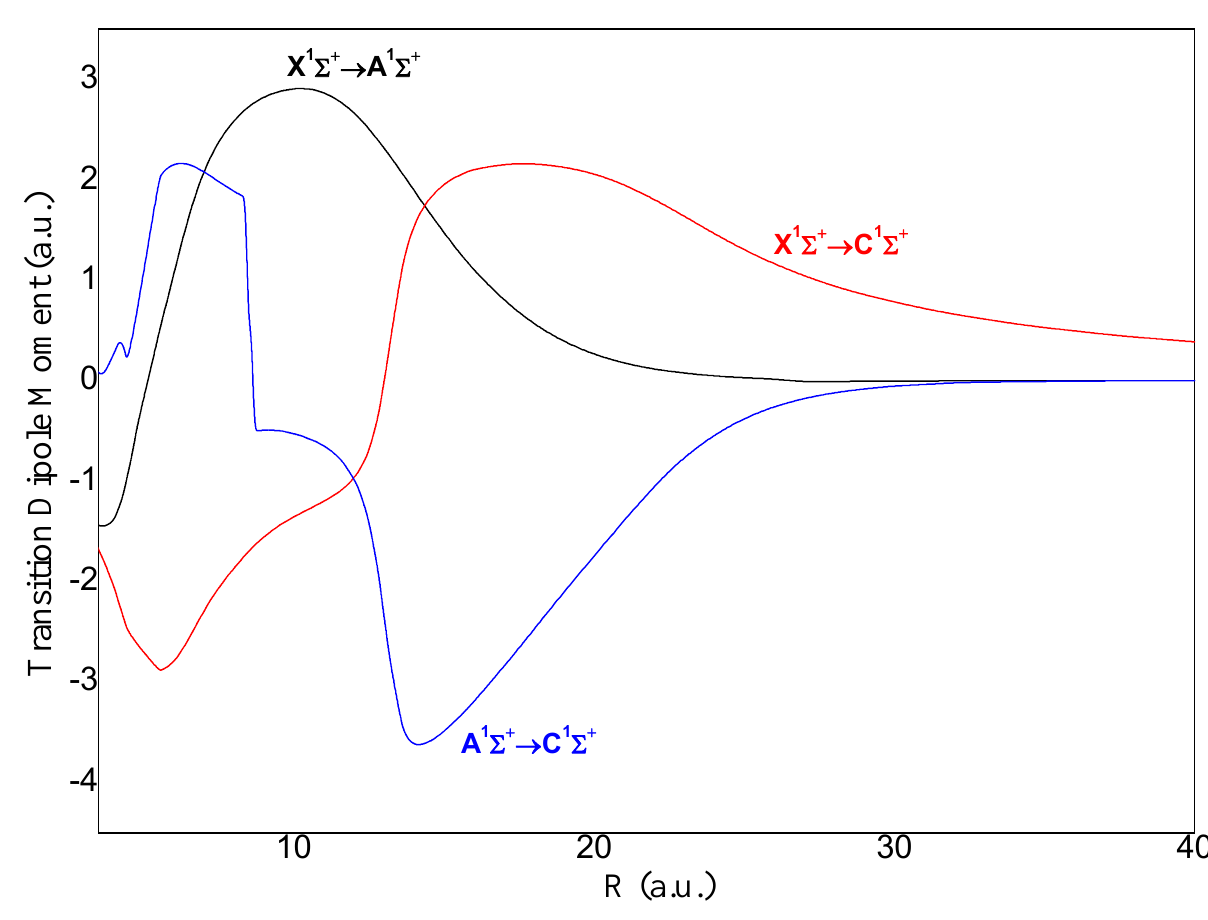
Figure 2. Adiabatic transition dipole moment of: (X-A), (X-C) and (A-C) 1 Σ + of (SrK) + .